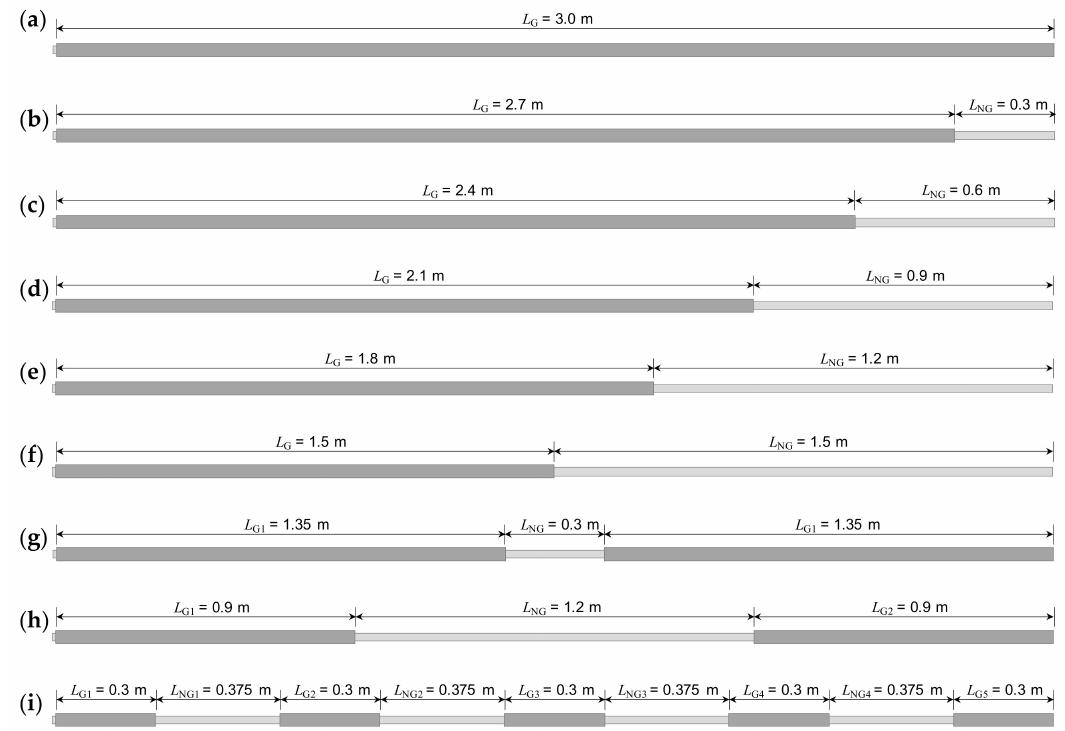
Figure 6. Rock bolt specimens for experiments in non-embedded condition.